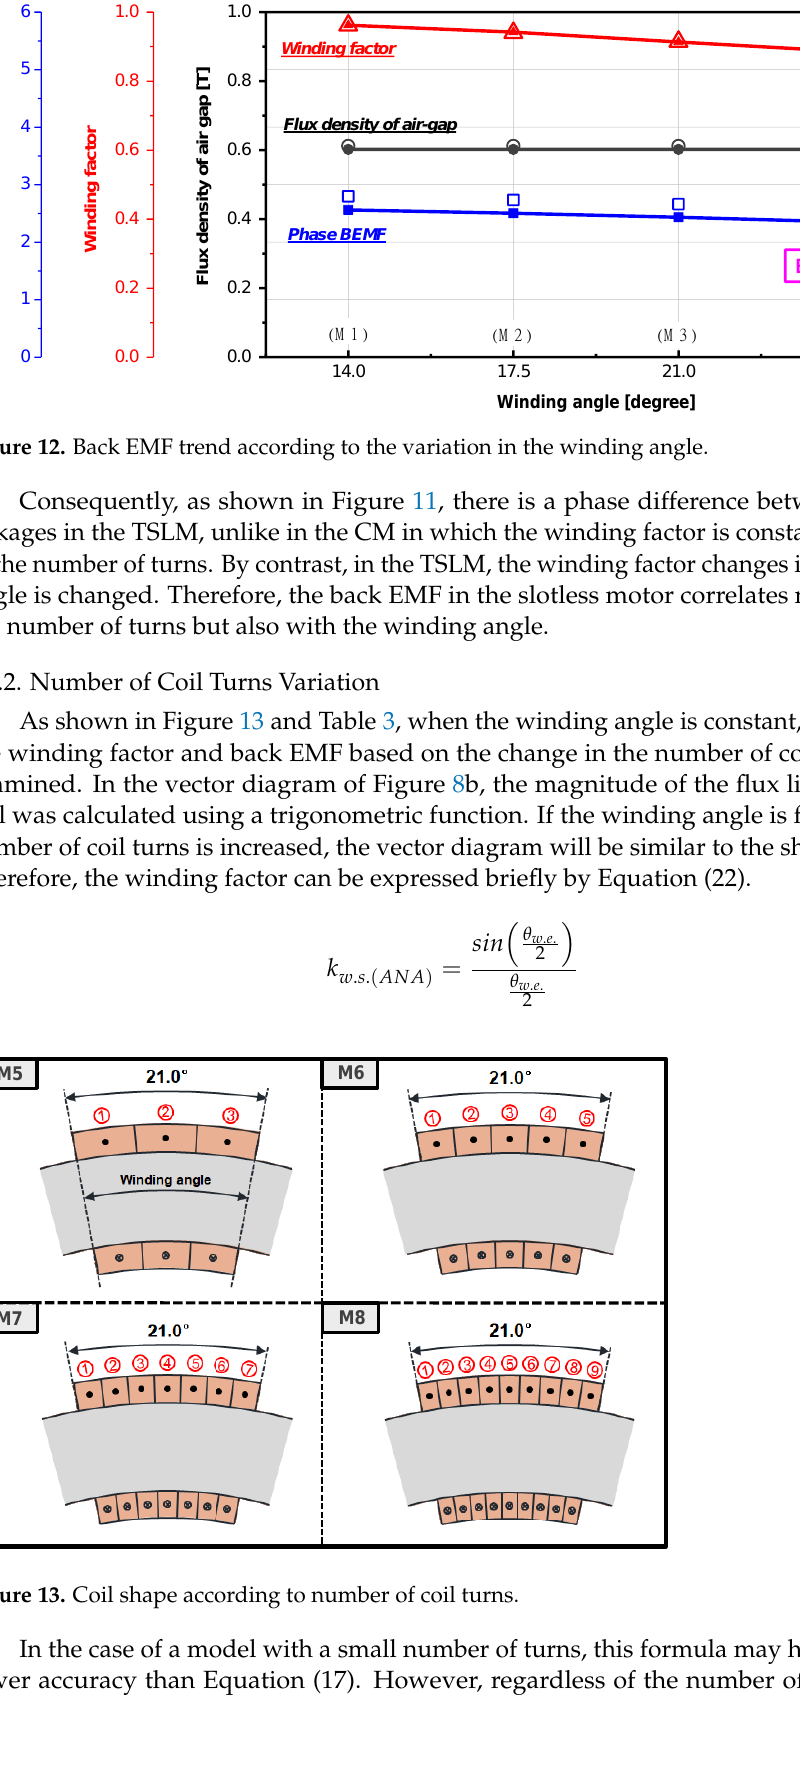
Figure 11. Total flux linkage and each flux-linkage waveform of M3.